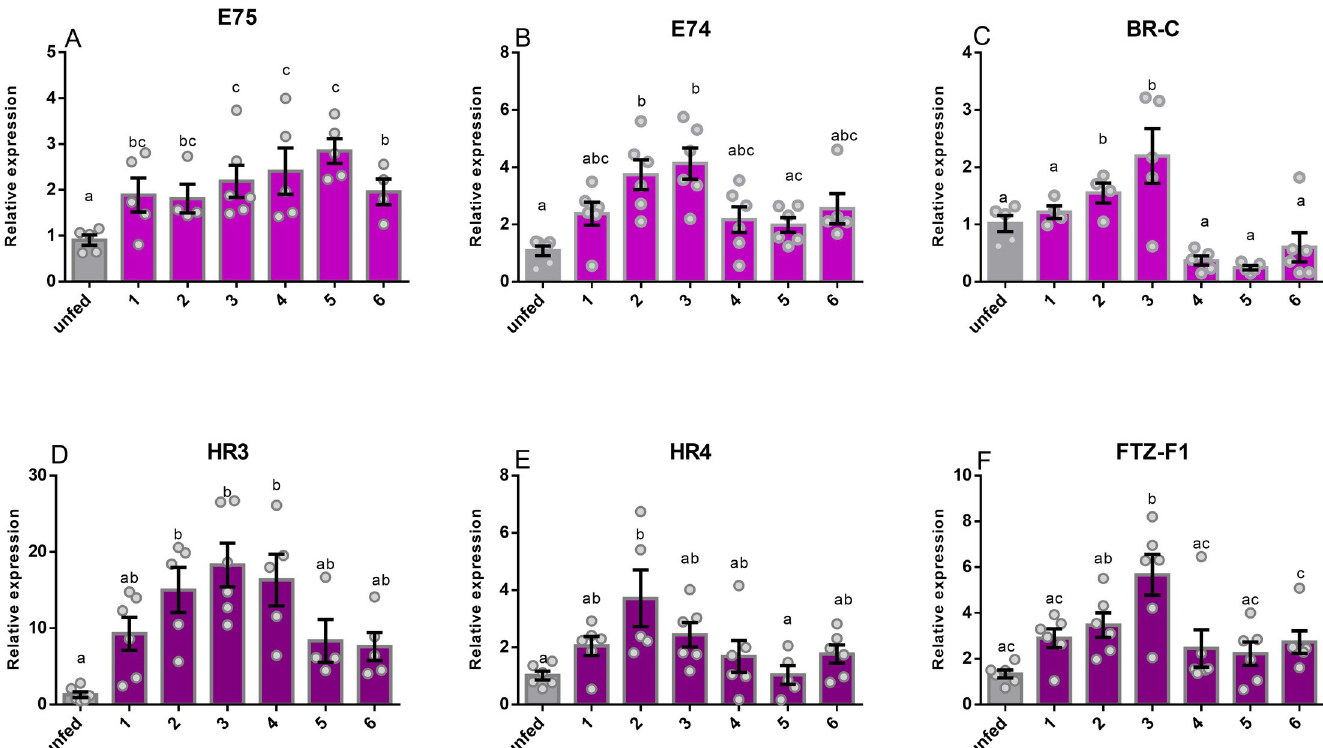
Fig 3. Temporal transcript expression of ecdysone response genes in ovaries. Two ovaries were pooled from adult female insects and analyzed from unfed and at 1, 2, 3, 4, 5, and 6 days post blood meal (PBM) and transcript levels were quantified by RT-qPCR. The expression of ecdysone response genes including E75 ( A ), E74 ( B ), BR-C ( C ), HR3 ( D ), HR4 ( E ), and FTZ-F1 ( F ) were measured. The y axis represents the fold change in expression relative to unfed (value ~ 1) obtained via geometric averaging using 18S rRNA and β -actin as reference genes. The transcript levels were quantified using RT-qPCR and analyzed using the 2 − ΔΔ Ct method. The results are shown as the mean ± SEM (n = 4–6). Statistical analysis was performed with one-way ANOVA and Tukey’s test for post hoc analysis. Means with significant differences (P < 0.05) from others are denoted by different letters.